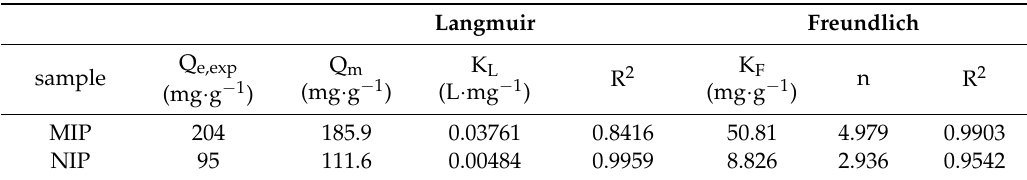
Table 4. Langmuir and Freundlich isotherm model parameters for the MIPs and NIPs on 60 µ m spherical silica.